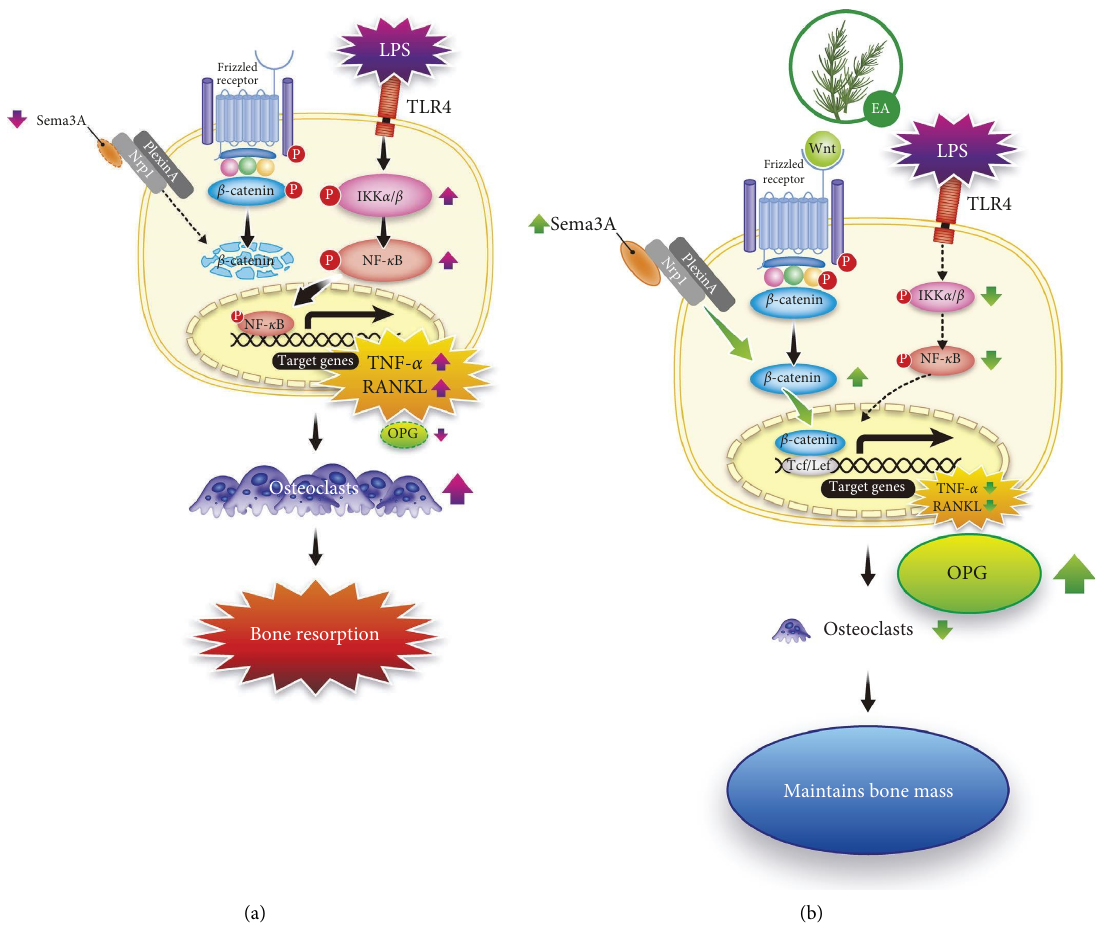
Figure 6: Proposed mechanism of EA inhibition of osteoclast formation caused by LPS. (a) In LPS-induced periodontitis, TLR4-mediated phosphorylation of I κ B kinase α and β (IKK α / β ) and NF- κ B induces the expression of infammatory cytokines such as tumor necrosis factor (TNF)- α in periodontal tissue cells and the generation of the osteoclastogenic receptor activator of NF- κ B ligand (RANKL), an osteo- clastogenic factor. However, it inactivates the Wnt/ β -catenin signaling pathway and promotes β -catenin degradation. Furthermore, production of the secreted protein semaphorin 3A (Sema3A) is decreased; Sema3A/neuropilin-1 (Nrp1)-mediated β -catenin degradation and nuclear translocation are suppressed, as is transcription and expression of osteoprotegerin (OPG), the decoy receptor for RANKL. Finally, the RANKL/OPG ratio is increased, leading to osteoclast formation and maturation and subsequent bone resorption. (b) Proposed mechanism of EA-induced suppression of osteoclastogenesis by LPS: EA strongly suppresses the activation of IKK α / β and NF- κ B, indicating that the Wnt/ β -catenin signaling pathway is activated and β -catenin degradation is suppressed. Furthermore, Sema3A production is elevated, Sema3A/Nrp1-mediated β -catenin degradation is suppressed, and nuclear migration is promoted. Tis suppresses osteoclast formation and excessive bone